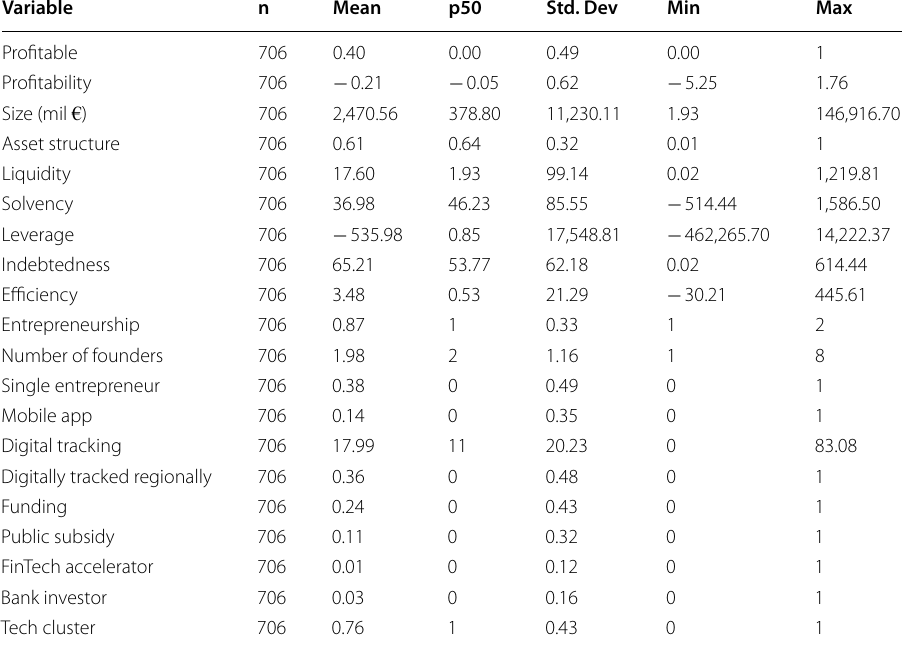
Table 3 Summary